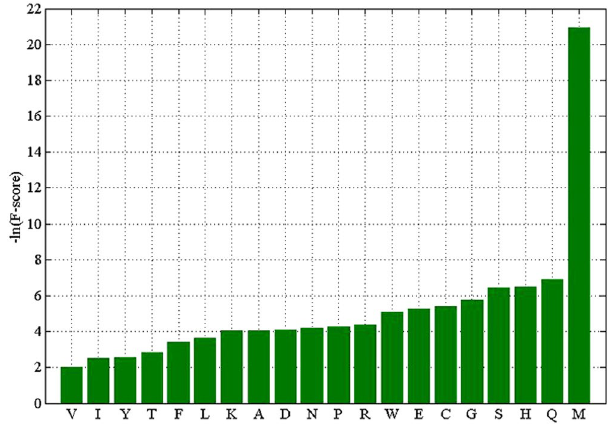
Figure 3. The F-scores of 20 amino acids. In this figure, x-axis represents the 20 amino acids, y-axis represents the-ln (F-score).